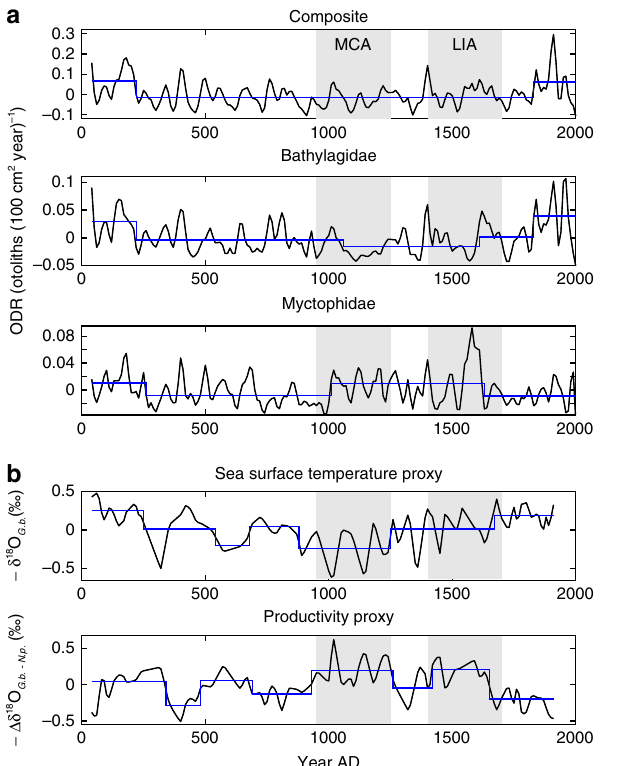
Fig. 3 Otolith deposition rate and environmental proxies. a Otolith deposition rate (ODR) for Composite (all classi fi ed otoliths, n otoliths = 1188), Bathylagidae ( n otoliths = 367) and Myctophidae ( n otoliths = 413). 10-year binned ODR time series ( n bins = 197) were detrended. Resulting anomaly time series were averaged using a 4-bin (40-years) double-running mean (black lines, see Methods section). b Proxies for sea surface temperature and primary productivity (10-year bins, n bins = 188, black lines). Blue lines are results from Sequential t Test Analysis of Regime Shifts (Methods) with a cutoff length, l , of 20-bins (200 years) and a signi fi cance value, p , of 0.05 (two-tailed). Discontinuities indicated by vertical blue lines. Mean values indicated by horizontal blue lines. Gray indicates Medieval Climate Anomaly (MCA) and Little Ice Age (LIA) (ref. 29 ). Source data are provided